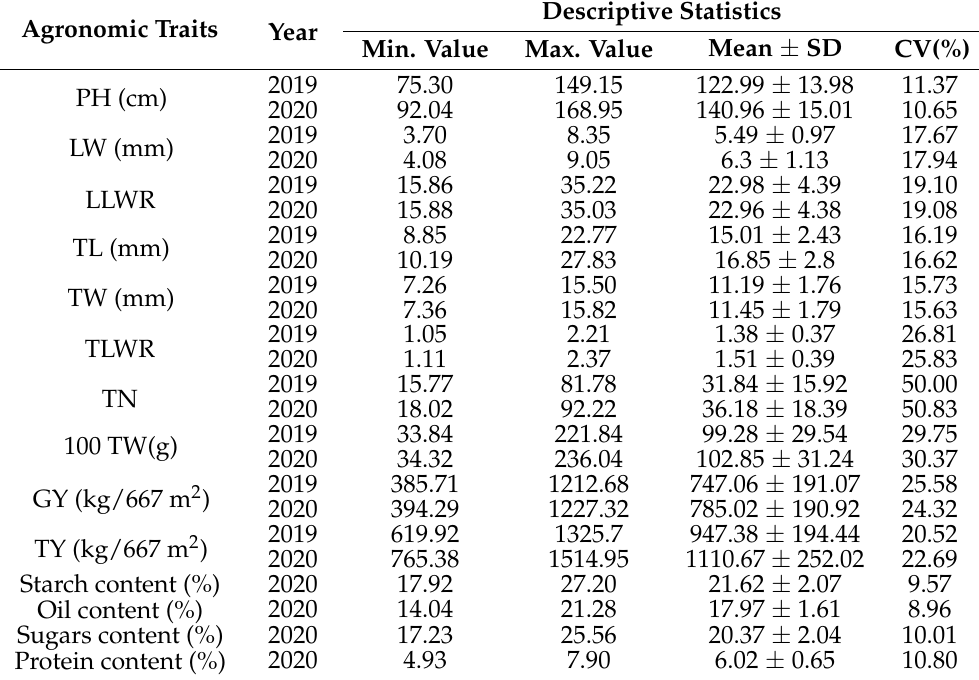
Table 2. Descriptive statistics of agronomic and biochemical traits under field conditions.